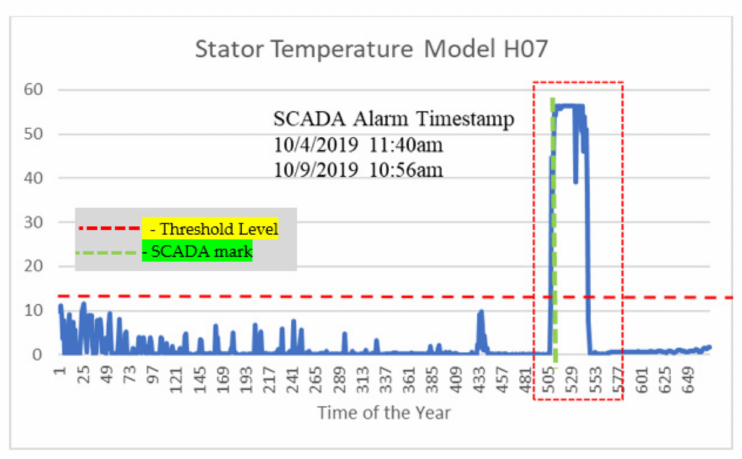
Figure 5. Mahalanobis distance based on the stator temperature model for H07.